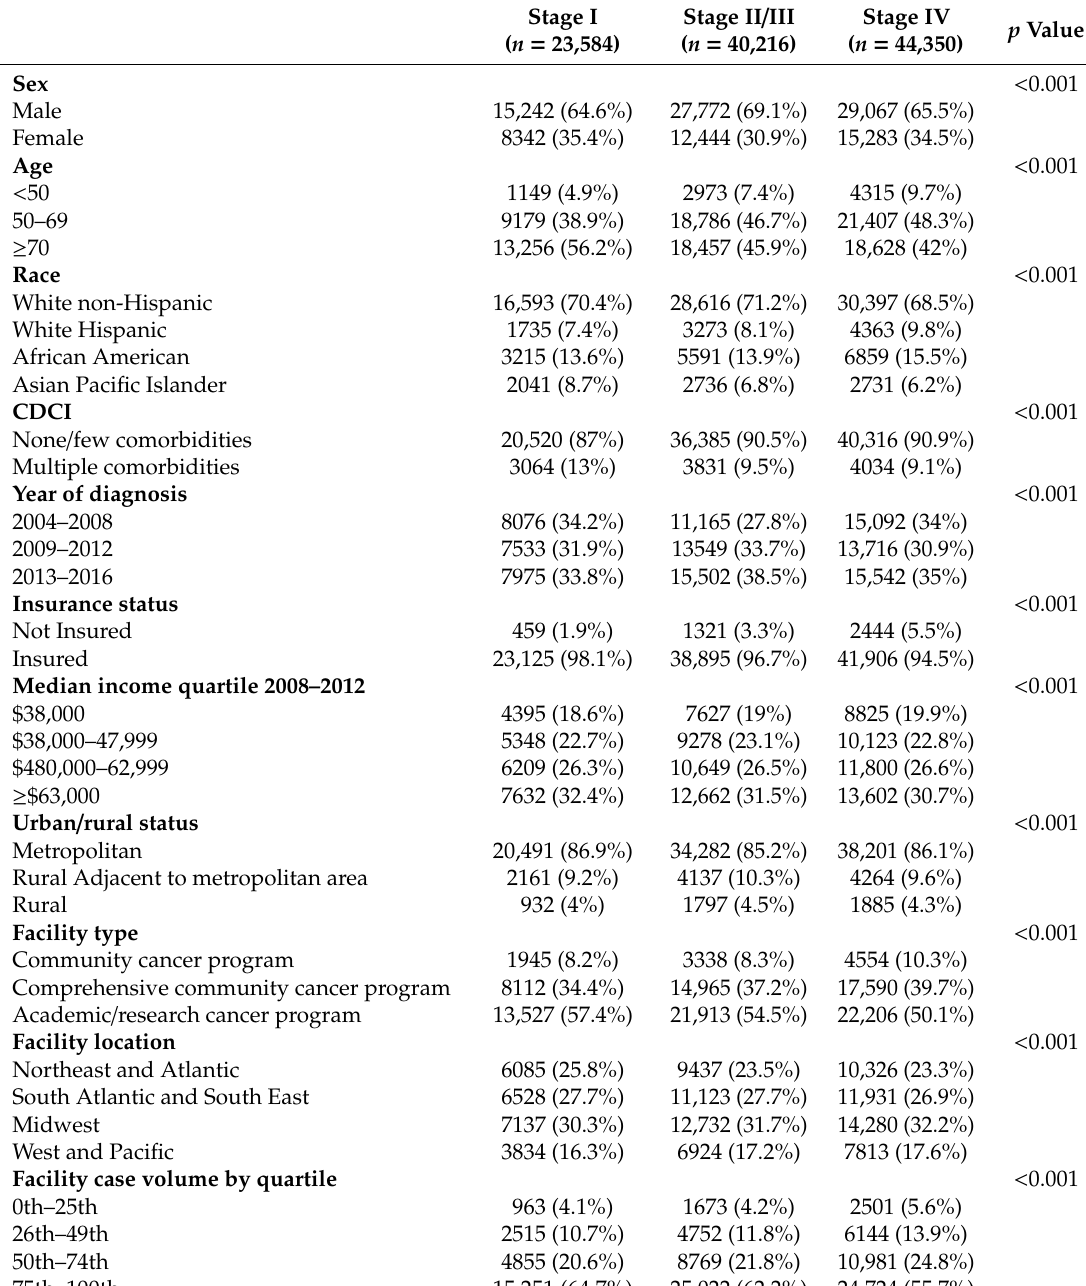
Table 1. Demographics of the Entire Cohort, n =